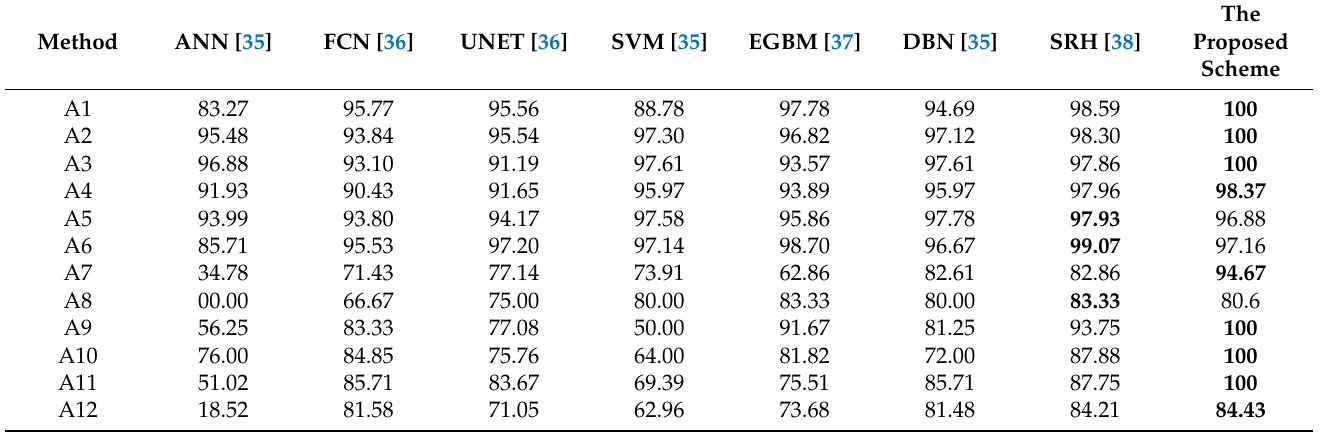
Table 6. The comparison of recall of 12 types of activities using different schemes in UCI data